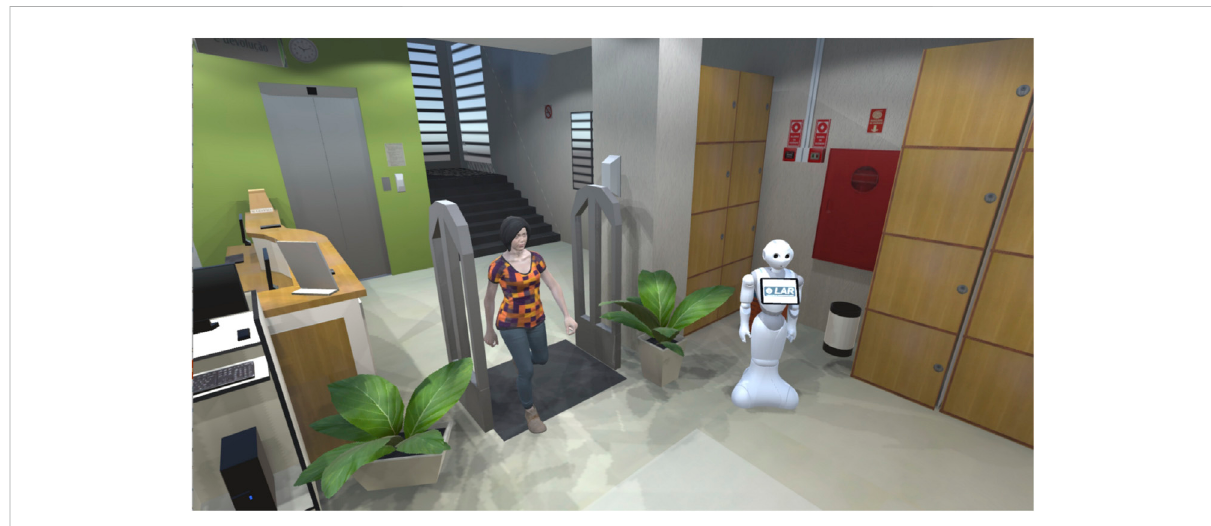
FIGURE 6 SimDRLSR environment overview. The simulator was developed with Unity Game